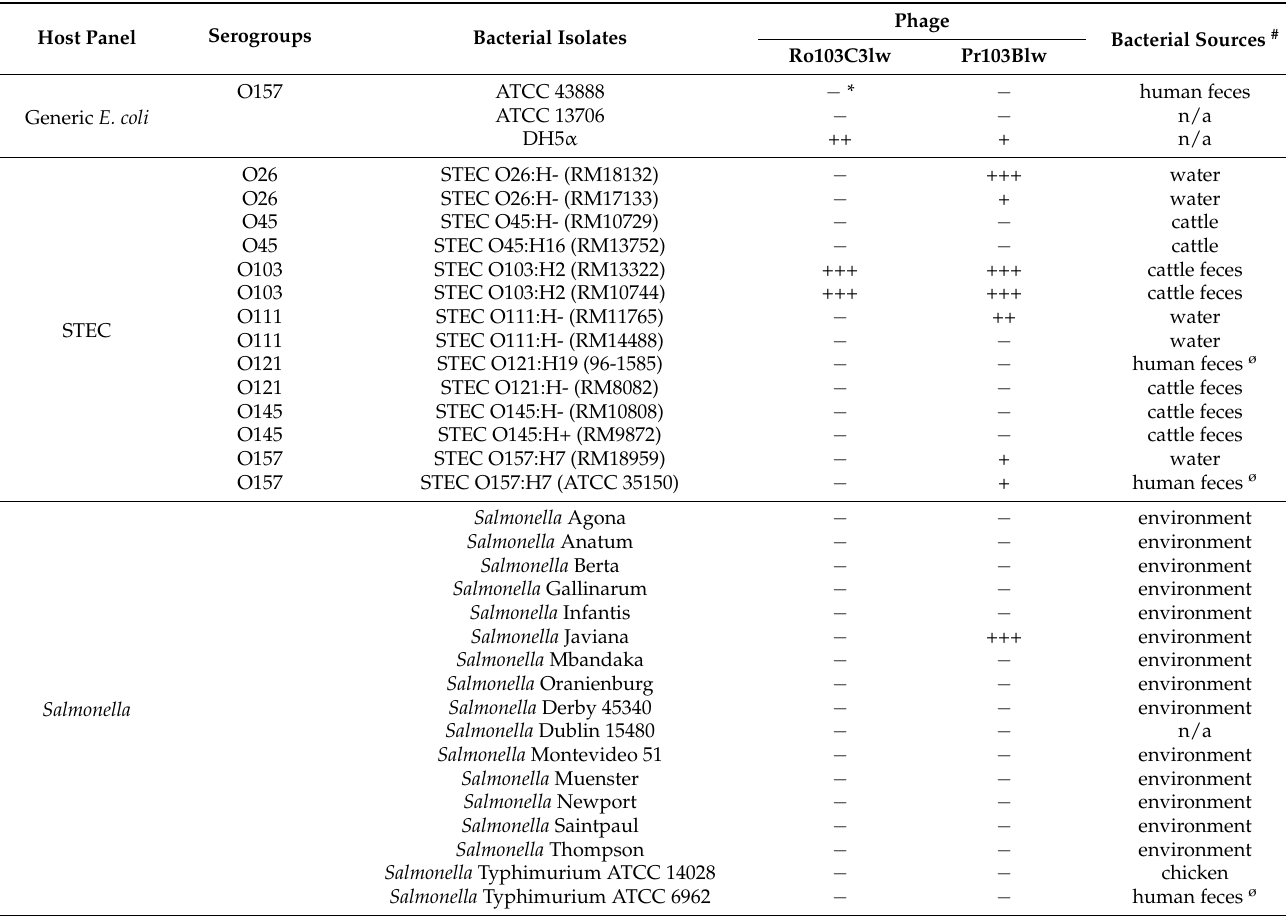
* indicates the degree of lysis using a cross mark, “+” indicates weak lysis, “++” indicates medium lysis, “+++” indicates complete lysis, and “–” indicates no lysis. # The bacterial sources are the type of environmental samples where the strain was originally isolated from; n/a means the information of the bacterial isolation source is not available; environment means bacteria was isolated from environmental samples, but the information about the sample type is unavailable. ø The strain was associated with foodborne